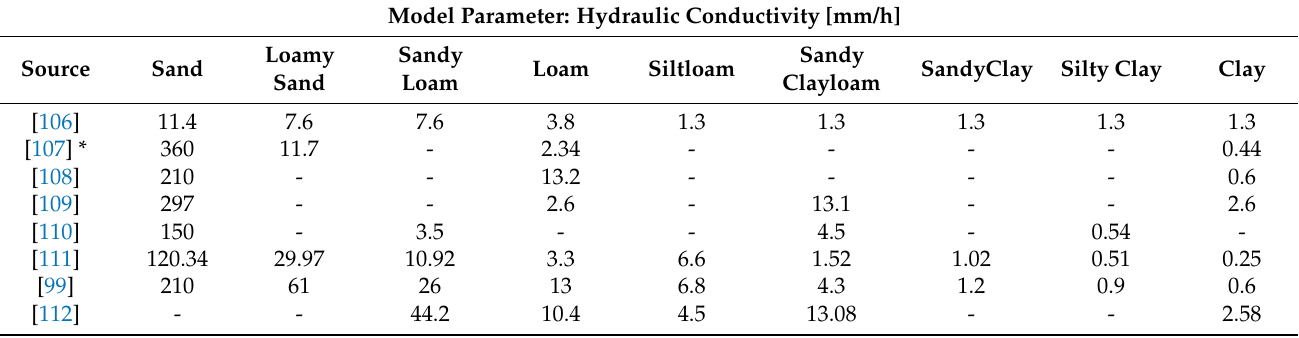
Table A3. Overview of the parameter hydraulic conductivity for urban flood